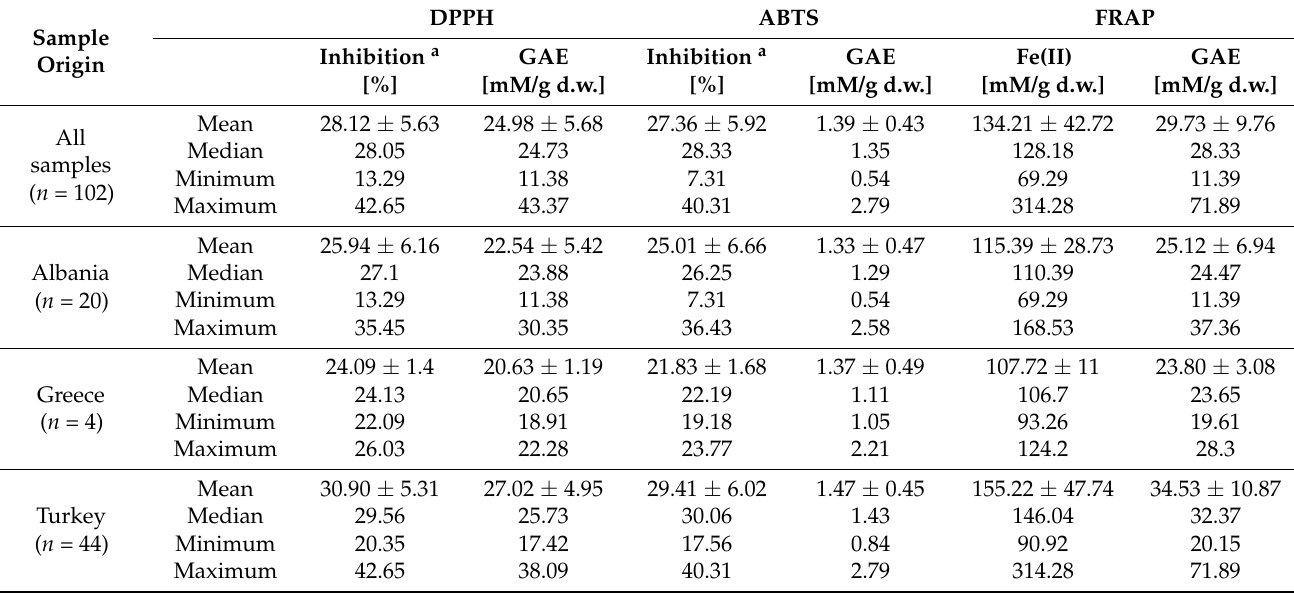
Table 3. Antioxidant activity of C. incanus water